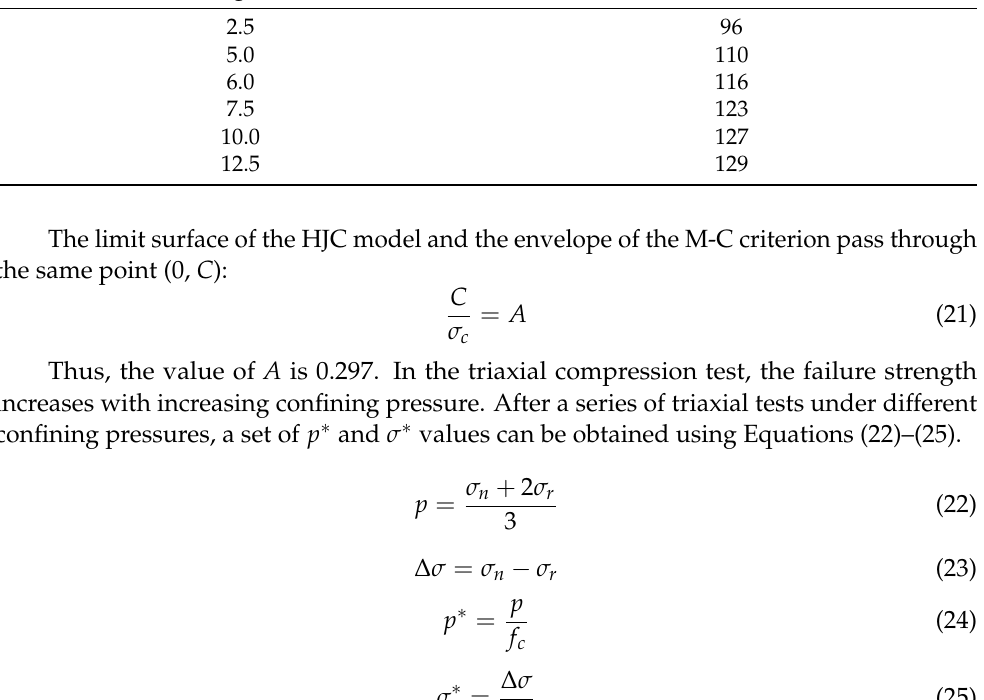
Table 3. The axial compressive strength under different confining pressures. Confining Pressure